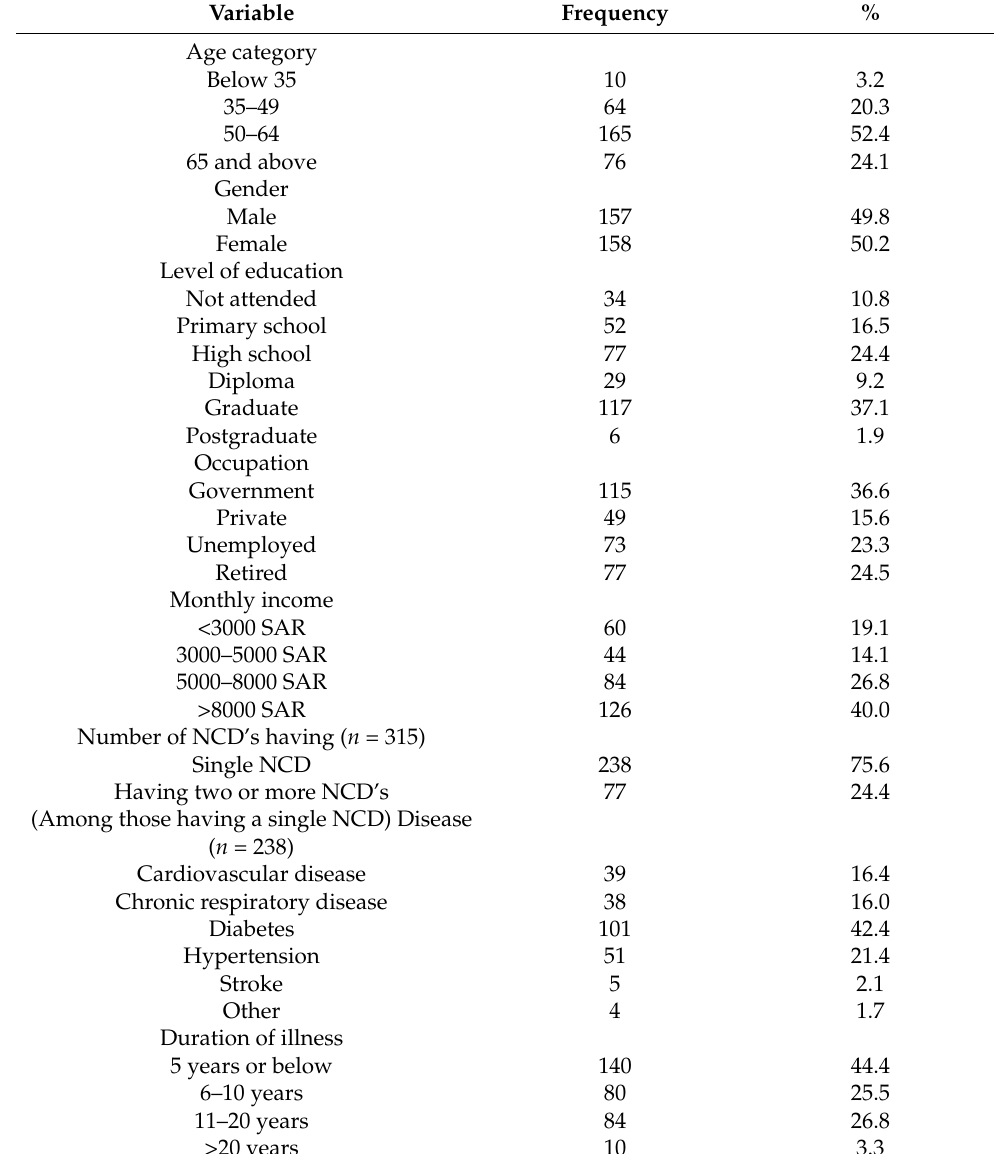
Table 1. Sociodemographic and medical characteristics of the 315